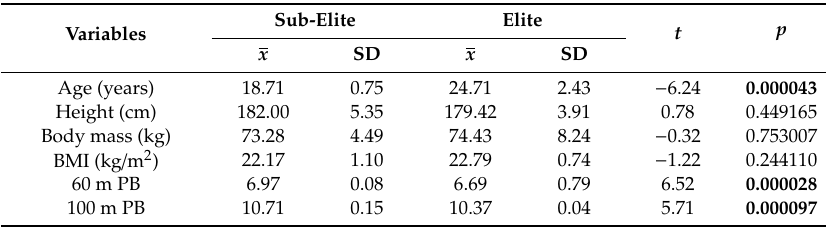
Table 3. Descriptive statistics and Student’s t -test results of group age, anthropometric characteristics, and personal best (PB)